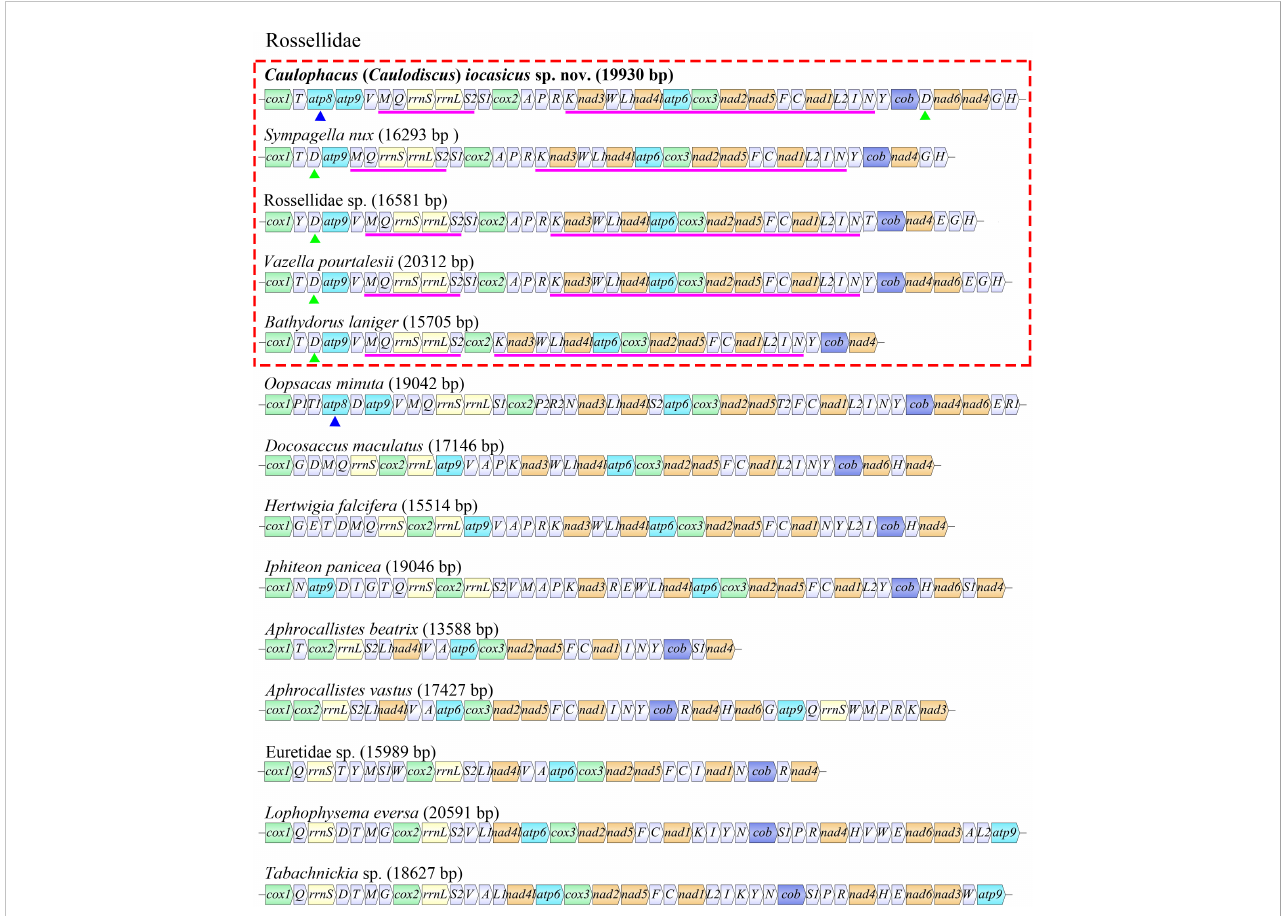
FIGURE 7 Mitochondrial gene organization and gene rearrangement in Hexactinellida. The length of mitochondrial genomes is presented in brackets. Conserved gene blocks within Rossellidae are shown in pink line; gene arrangements of tRNA D within Rossellidae are shown as green triangles; = atp8 genes are shown as blue